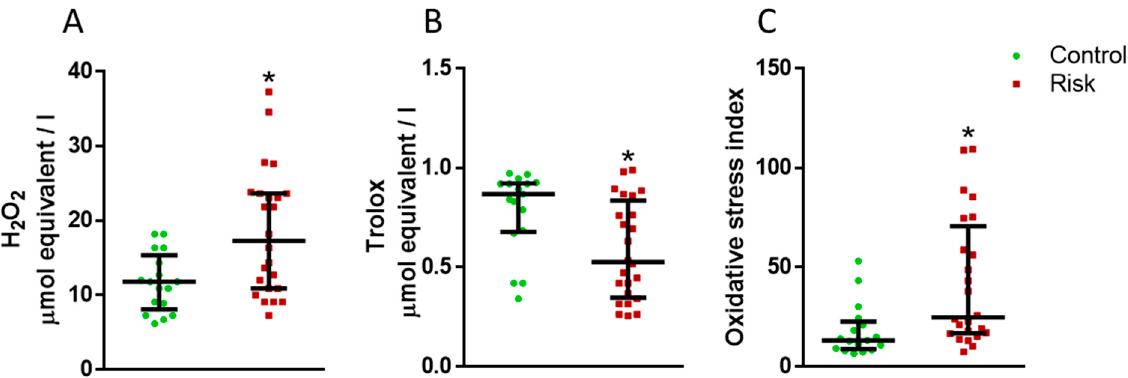
Figure 3. Total oxidant status ( A ), total antioxidant status ( B ), and oxidative stress index ( C ) in the plasma of patients in the control group and in patients at risk of developing Parkinson’s disease. * p < 0.05, statistically significant differences. Data presented as a median with an interquartile range and min–max values.